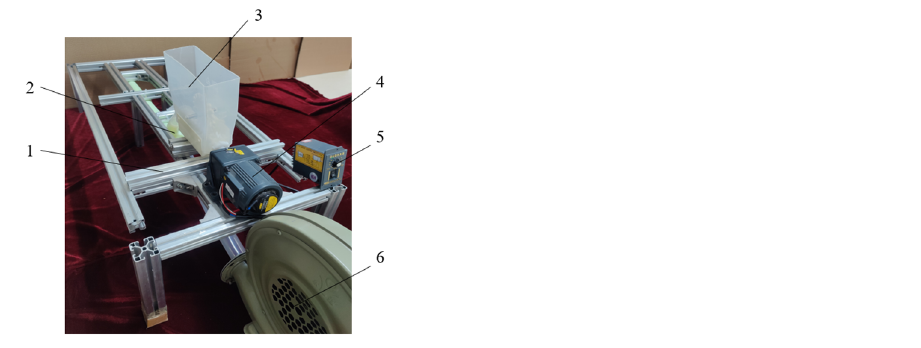
Figure 10. Test bench (1. Rack; 2. Venturi tube; 3. Mixed seed box; 4. Stepper motor; 5. Governor; 6. Fan).